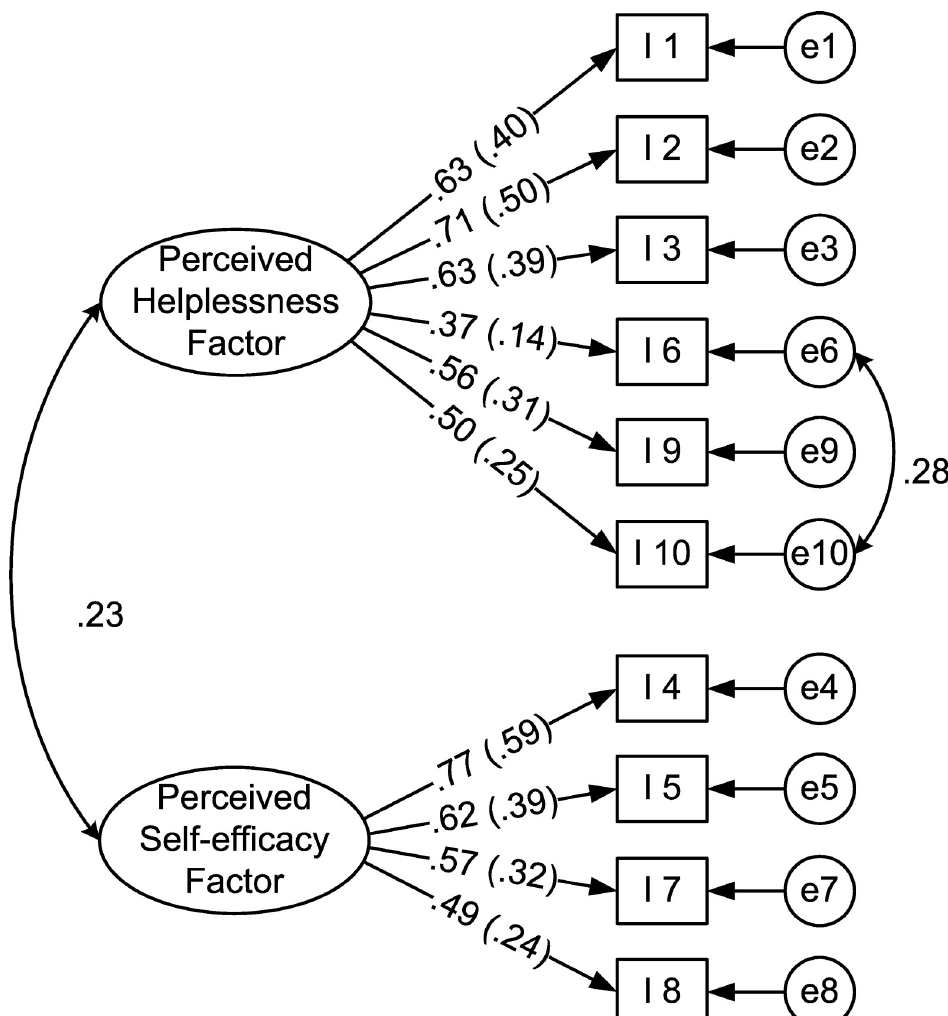
Fig 1. Modified CFA model of the Bengali PSS-10. Communalities are presented in the parentheses. I 1—I 10 indicate item numbers, and e1—e10 represent error terms for respective